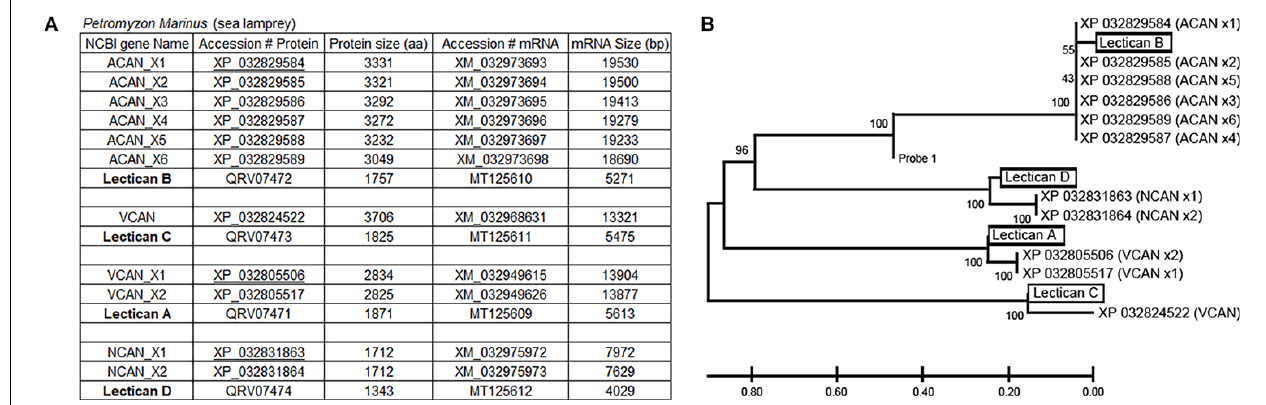
FIGURE 4 | Analysis of lamprey lectican family. (A) A table summary of the lamprey lectican family found in the NCBI database. The protein sequences are predicted by automated computational analysis of the sequenced lamprey genome, annotated using the Gnomon gene prediction method and named as ACAN: Aggrecan; VCAN: Versican; NCAN: Neurocan. X represents a variant of each family member. The alignments of the variant sequences of each member are shown in Supplementary Figure 1 . The sequences of lecticans A, B, C, and D (in bold) are published in NCBI and by Root et al. (2021). They are assembled from four different lamprey genomic scaffolds containing exons with sequence similarities to those of jawed vertebrate lecticans. The designation of lamprey lecticans as A, B, C and D is due to the lack of a clear one-to-one orthology with gnathostome lecticans. (B) Phylogenetic analysis shows the identities of lamprey lecticans, A, B, C, and D, which are highlighted in boxes and grouped in the table (A) with their closest homolog. However, alignments show that lectican A, B, C, and D are only partial and discontinuous sequences that are found in their homologous lecticans annotated by Gnomon (see Supplementary Figure 2